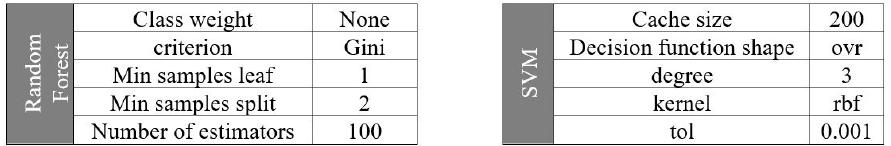
Figure 2. The parameters of models used in our